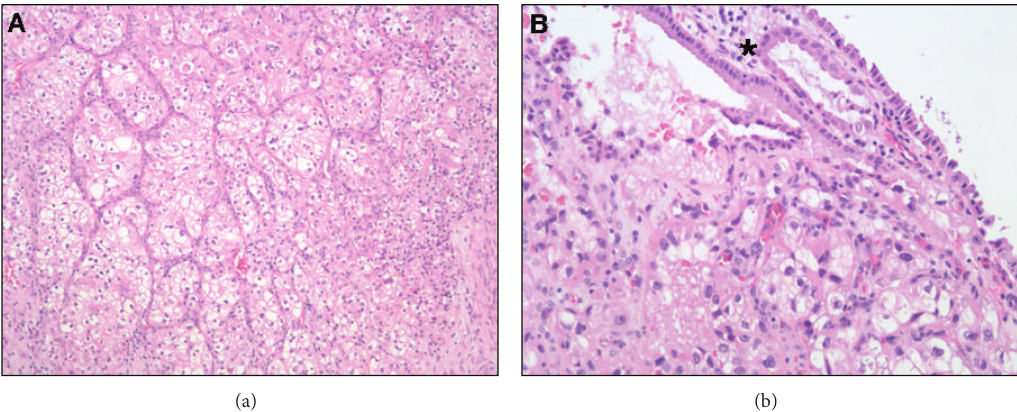
Figure 3: Histological examination of the gallbladder (hematoxylin eosin, (a) 100x and (b) 200x) showing metastatic clear cell renal cell carcinoma within the mucosa of the the gallbladder wall. The mucosa of the gallbladder wall is marked with an asterisk in